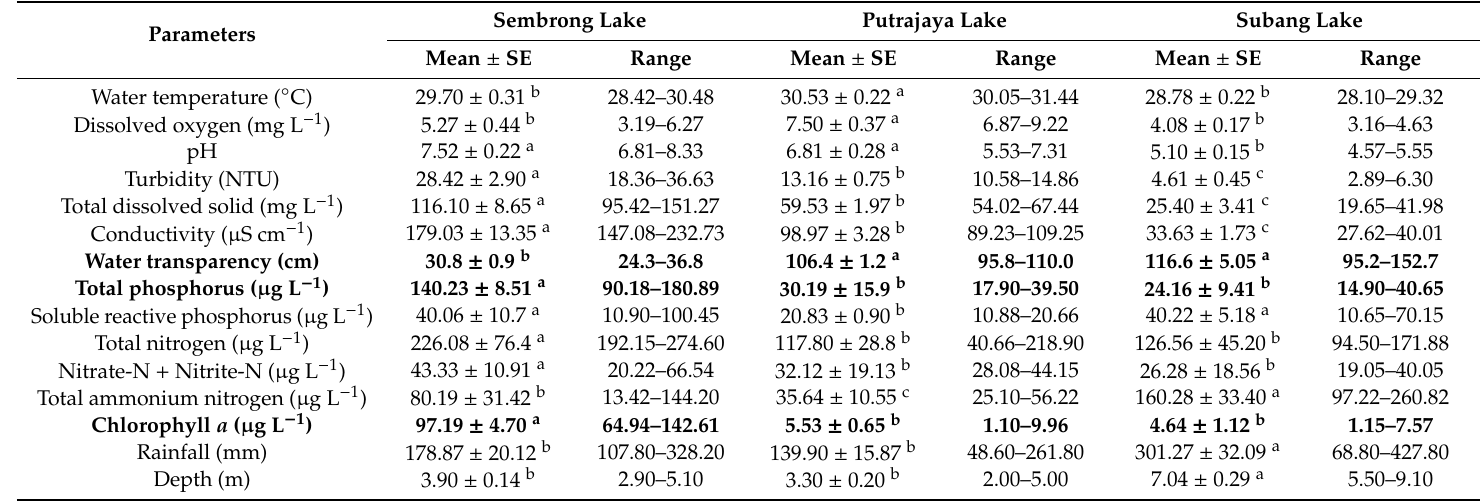
Table 1. Means and ranges of physical and chemical parameters in Sembrong, Putrajaya and Subang lakes. Mean values with di ff erent letters indicate significant di ff erence at p < 0.05. Mean value = mean ± SE ( n =